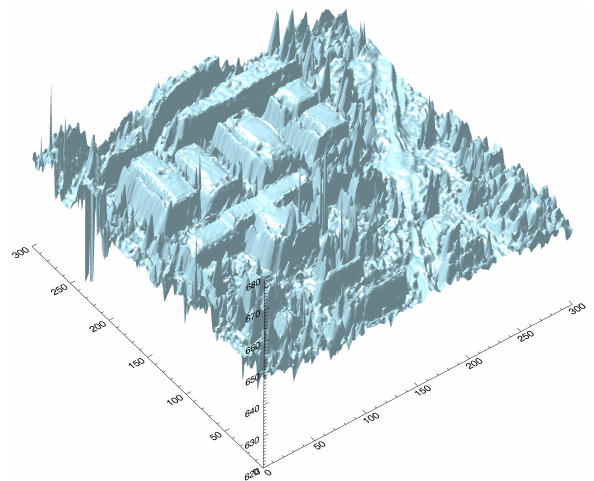
Figure 8: Three dimensional visualization of the DEM over Las Vegas for an industrial area experimentally generated using the NL-InSAR technique.